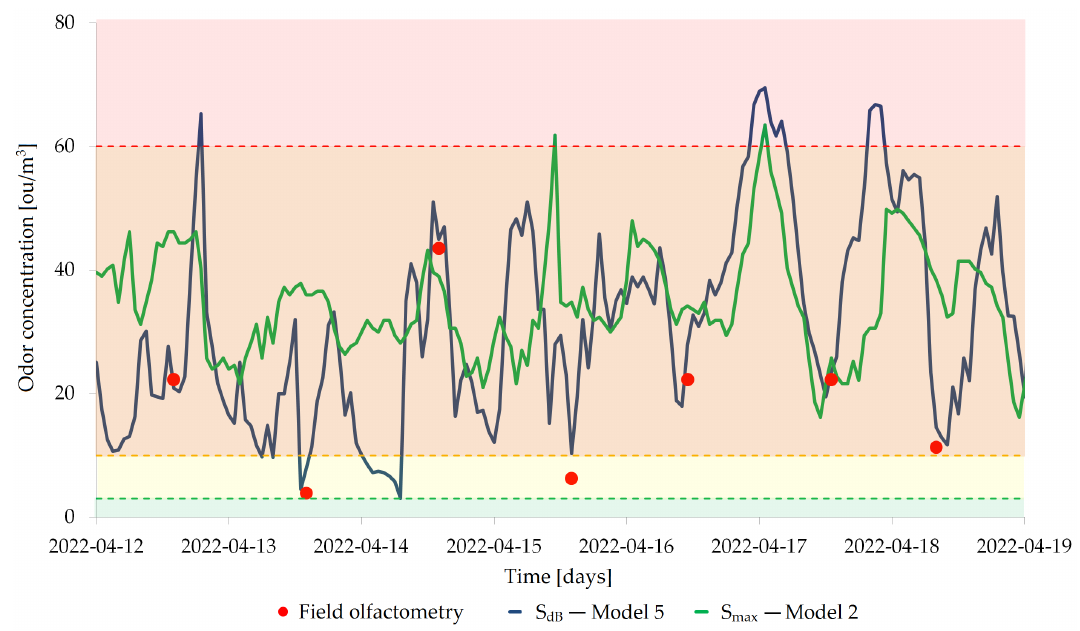
Figure 9. Weekly changes in odor concentrations at the compost screening site calculated using the best model developed using the maximum signal value and signal value in dB compared with field olfactometry